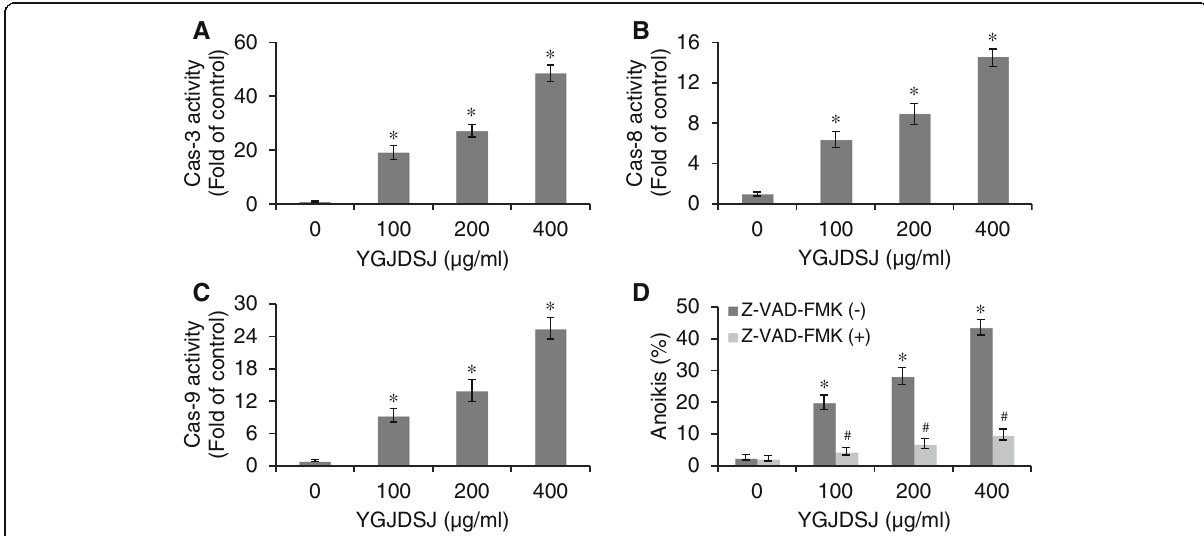
Fig. 3 YGJDSJ activated caspases in Bel-7402 cells. After 24 h YGJDSJ (100 – 400 μ g/ml) treatment, caspase-3 ( a ), caspase-3 ( b ) and caspase-9 ( c ) activities